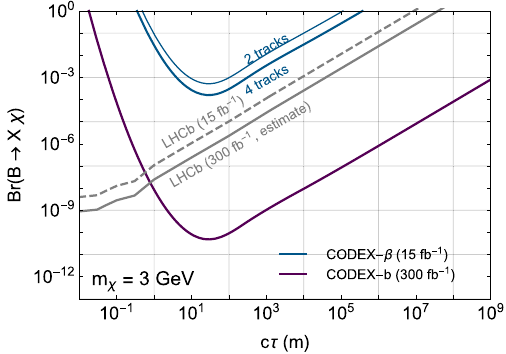
Fig. 29 CODEX- β reach for a long-lived χ decaying hadronically